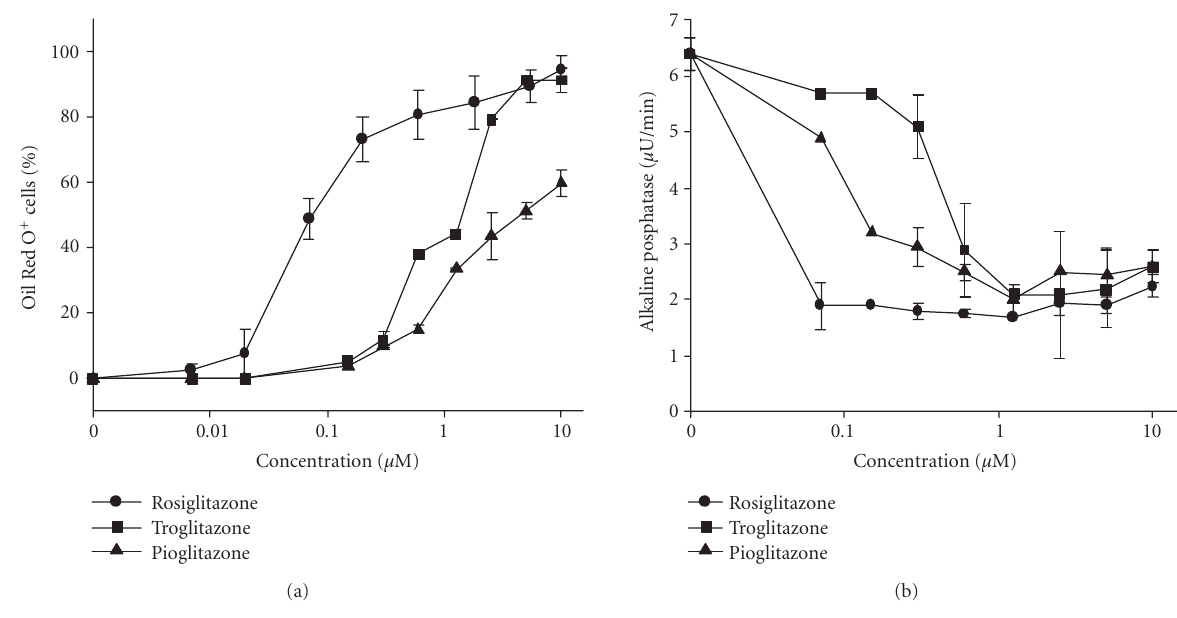
Figure 2: The e ff ect of tested glitazones on adipocyte (a) and osteoblast (b) phenotypes of U-33/ γ 2 cells. U-33/ γ 2 cells represent marrow mesenchymal bipotential progenitor cells, which di ff erentiation towards osteoblast and adipocyte is under the control of PPAR- γ 2 transcrip- tion factor. Cells were treated for 3 days with di ff erent doses of tested PPAR- γ agonists and cultures were either stained for fat with Oil Red-O or subjected to alkaline phosphatase enzyme activity assay as previously described [4].